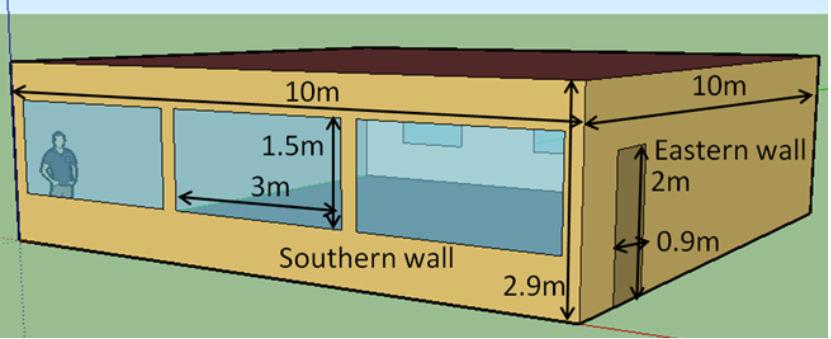
Figure 1. Schematic drawing of the tested prototypical single-family one-story building [37].